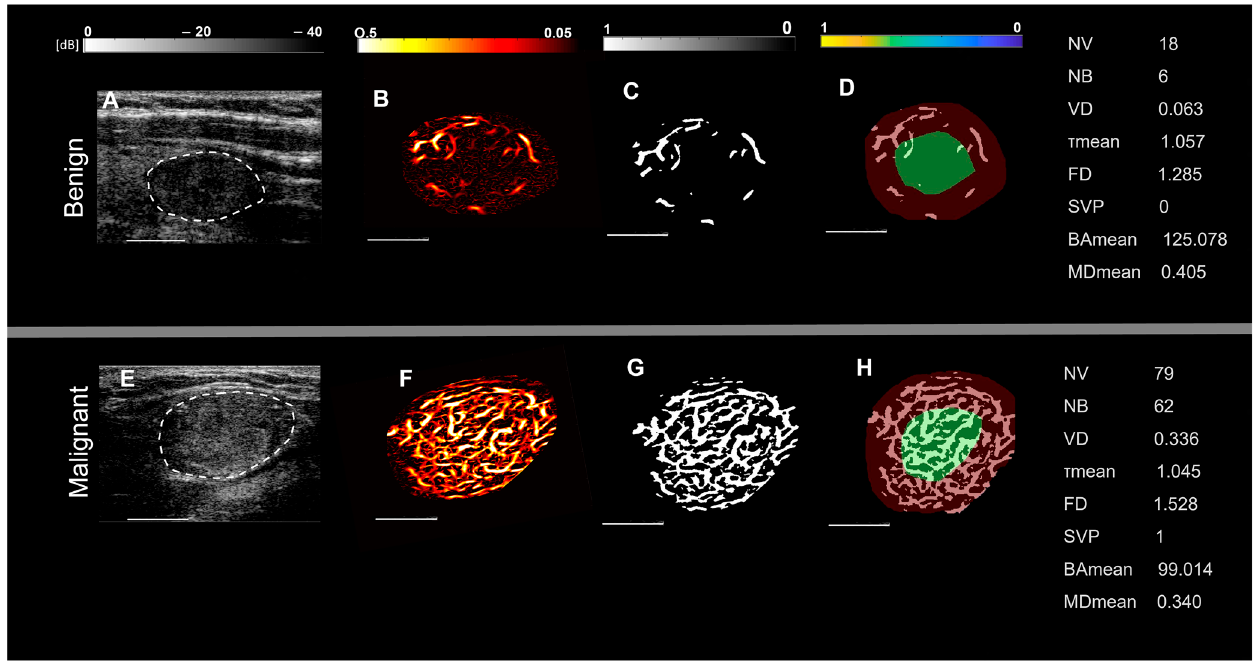
Figure 1. Representative images of large thyroid nodules > 20 mm, benign (top row) and malignant (bottom row). ( A , E ) are B-mode ultrasound images (dashed white circles delineate the boundaries of the nodules), ( B , F ) are HDMI images showing tumor microvessels, ( C , G ) are binary images of microvessels, ( D , H ) spatial vascularity pattern (SVP) diagrams (green circles represent the central region and the red ones the peripheral region of the nodule). The correspondent quantitative biomarkers are displayed on the right side of each row. The white line denotes a scale of 1